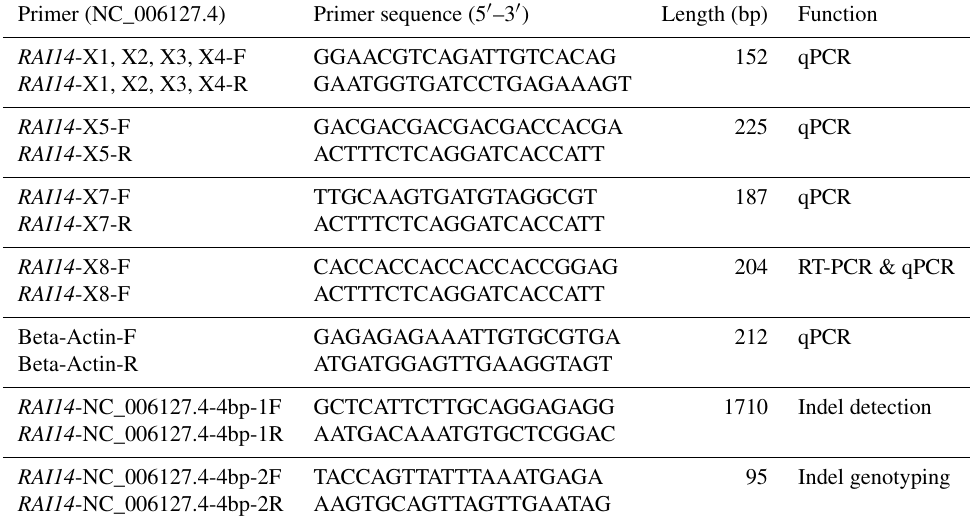
Table 1. Primers used for indel locus detection and expression analysis. Primer (NC_006127.4) Primer sequence (5 (cid:48) –3 (cid:48)